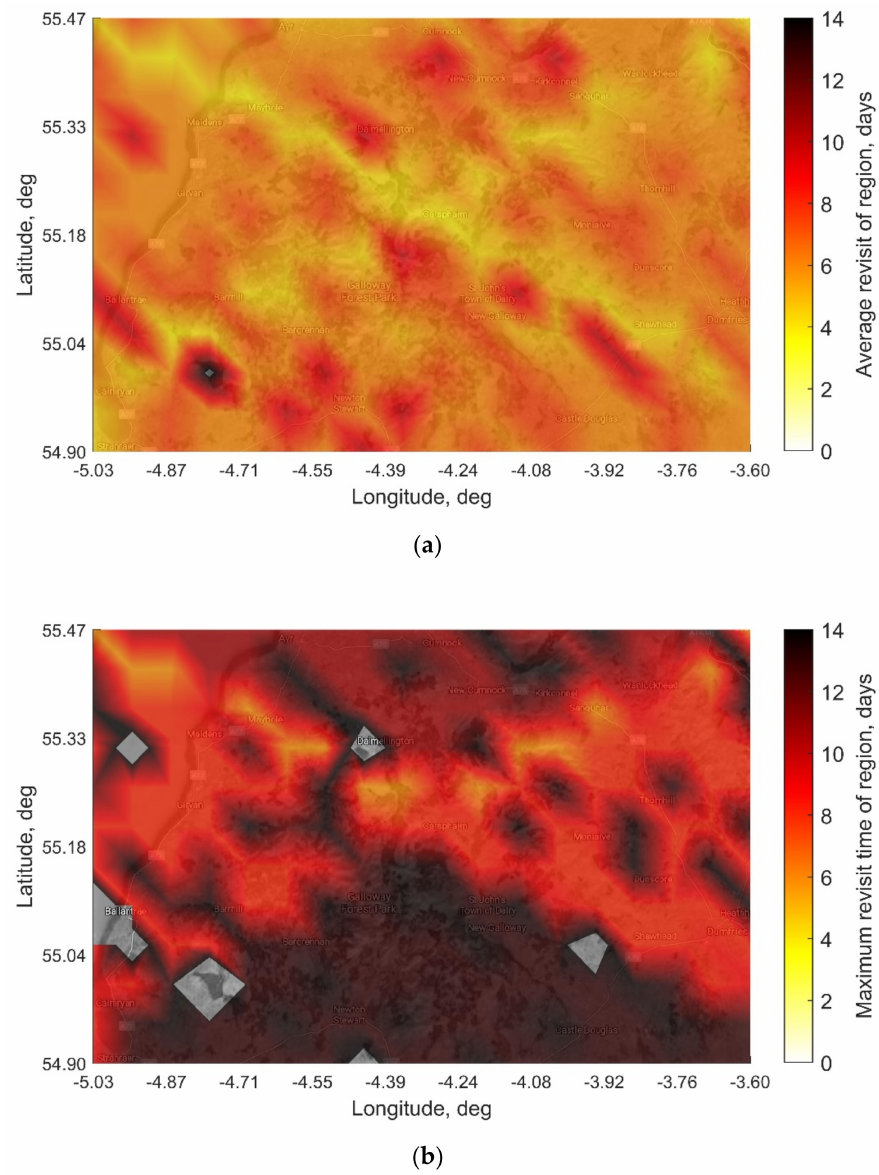
Figure 7. Maps of the south region of interest as described in Table 6 and indicated on Figure 2. The maps are oriented with north to the top and cover an area of approximately 63 km (N-S) × 90 km (E-W). The colours overlaid on the maps indicate the ( a ) average and ( b ) maximum revisit times of each location in the region after 30 days. Coverage is calculated at approximately 5 km intervals and interpolated to provide the coverage estimates for the full region of interest. (Map data: Google, TerraMetrics, www.google.com / maps [retrieved 16 March